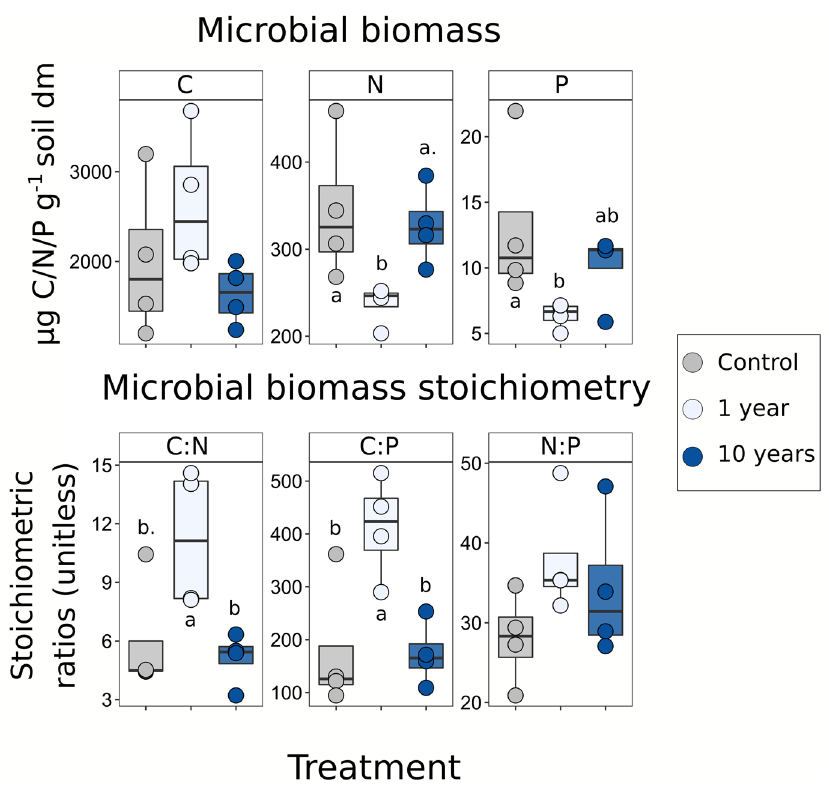
Fig. 1 Drought effects on microbial biomass C, N and P. Colour indicates soil treatment (control = grey, 1 year = light blue, 10 years = blue). The top graphs show microbial biomass carbon (MBC), nitrogen (MBN) and phosphorous (MBP). MBC was not signi fi cantly affected by drought ( F -value: 2.02, p = 0.18), while MBN and MBP were ( F -value: 5.7, p = 0.04, n = 4; F -value: 4.44, p = 0.06, n = 4). The same pattern was present in all the three values, where control and the 10-year treatment had similar values and the 1-year treatment was different. The bottom graphs show the stoichiometric ratios of microbial biomass. The ratio of C-to-N and C-to-P show similar results, where the 1-year treatment was signi fi cantly different from both control and 10 years (respectively, F -value: 5.72, p = 0.0249, n = 4; F -value: 8.06, p = 0.0098, n = 4). The ratio of N-to-P was not statistically affected by drought, and the 10-year treatment values ranged between the 1 year and control. Letters represent results from two-sided Tukey HSD post hoc test (a point next to letter represents a p -value on the 0.05 threshold). Box centre line represents median, box limits the upper and lower quartiles, whiskers the 1.5x interquartile range, while separated points represent outliers. The sample size ‘ n ’ represents biologically independent